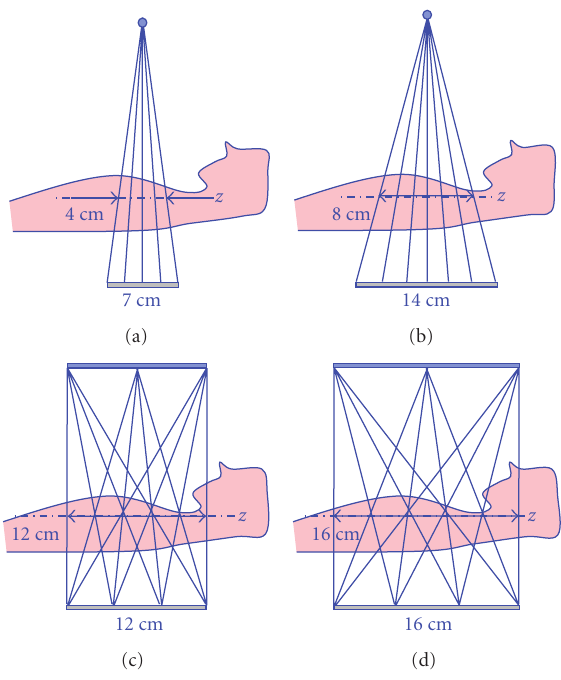
Figure 10: Illustration of proposed CT geometries: (a) and (b) are 3rd generation CT systems with 40 mm and 80mm coverage, and (c) and (d) are multi-axial acquisition CT systems with 120 mm and 160mm coverage. Note that the coverage of a multi-axial acquisition system is the same as detector size. 3rd generation system requires bigger detector for the same scan